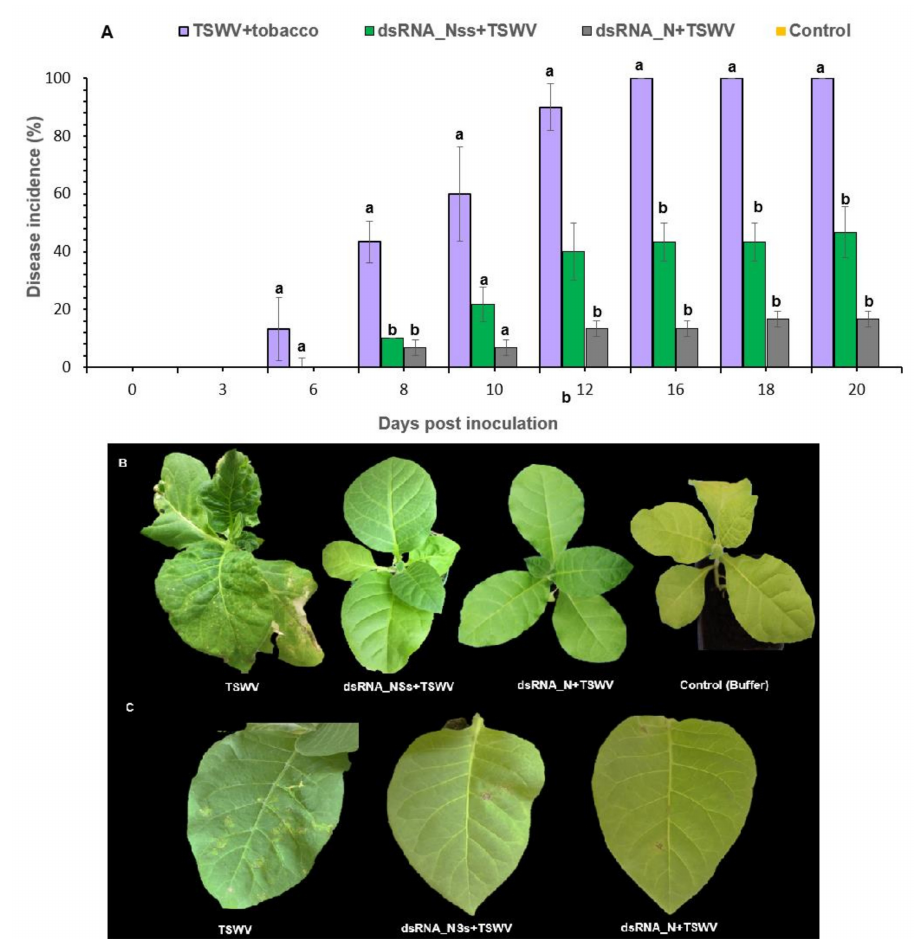
Figure 2. Effect of double-stranded RNA on tomato spotted wilt virus (TSWV) infection in tobacco. ( A ) TSWV + tobacco; dsRNA_N + TSWV; dsRNA_Nss + TSWV and Control (Buffer). Disease